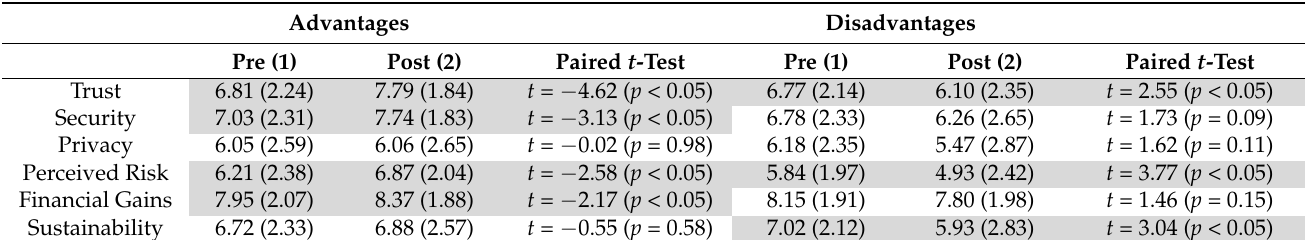
Table 3. Intragroup comparison before and after the